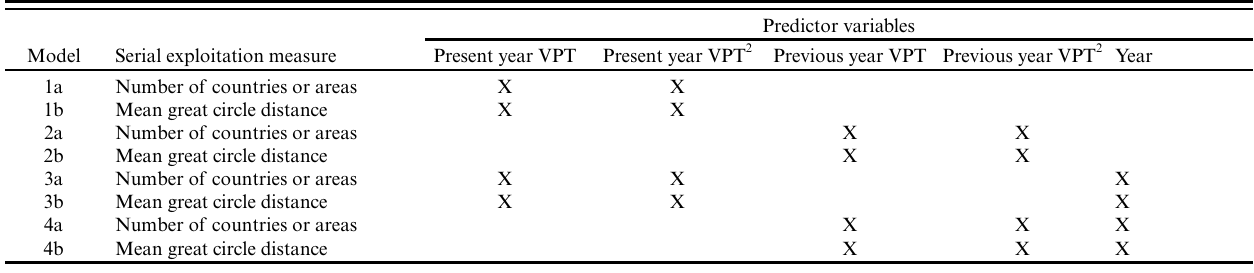
Table 1 . Predictor variables and measures of serial exploitation that were selected to be included in each model. X indicates that a certain term is included in a model (VPT: value per metric ton).